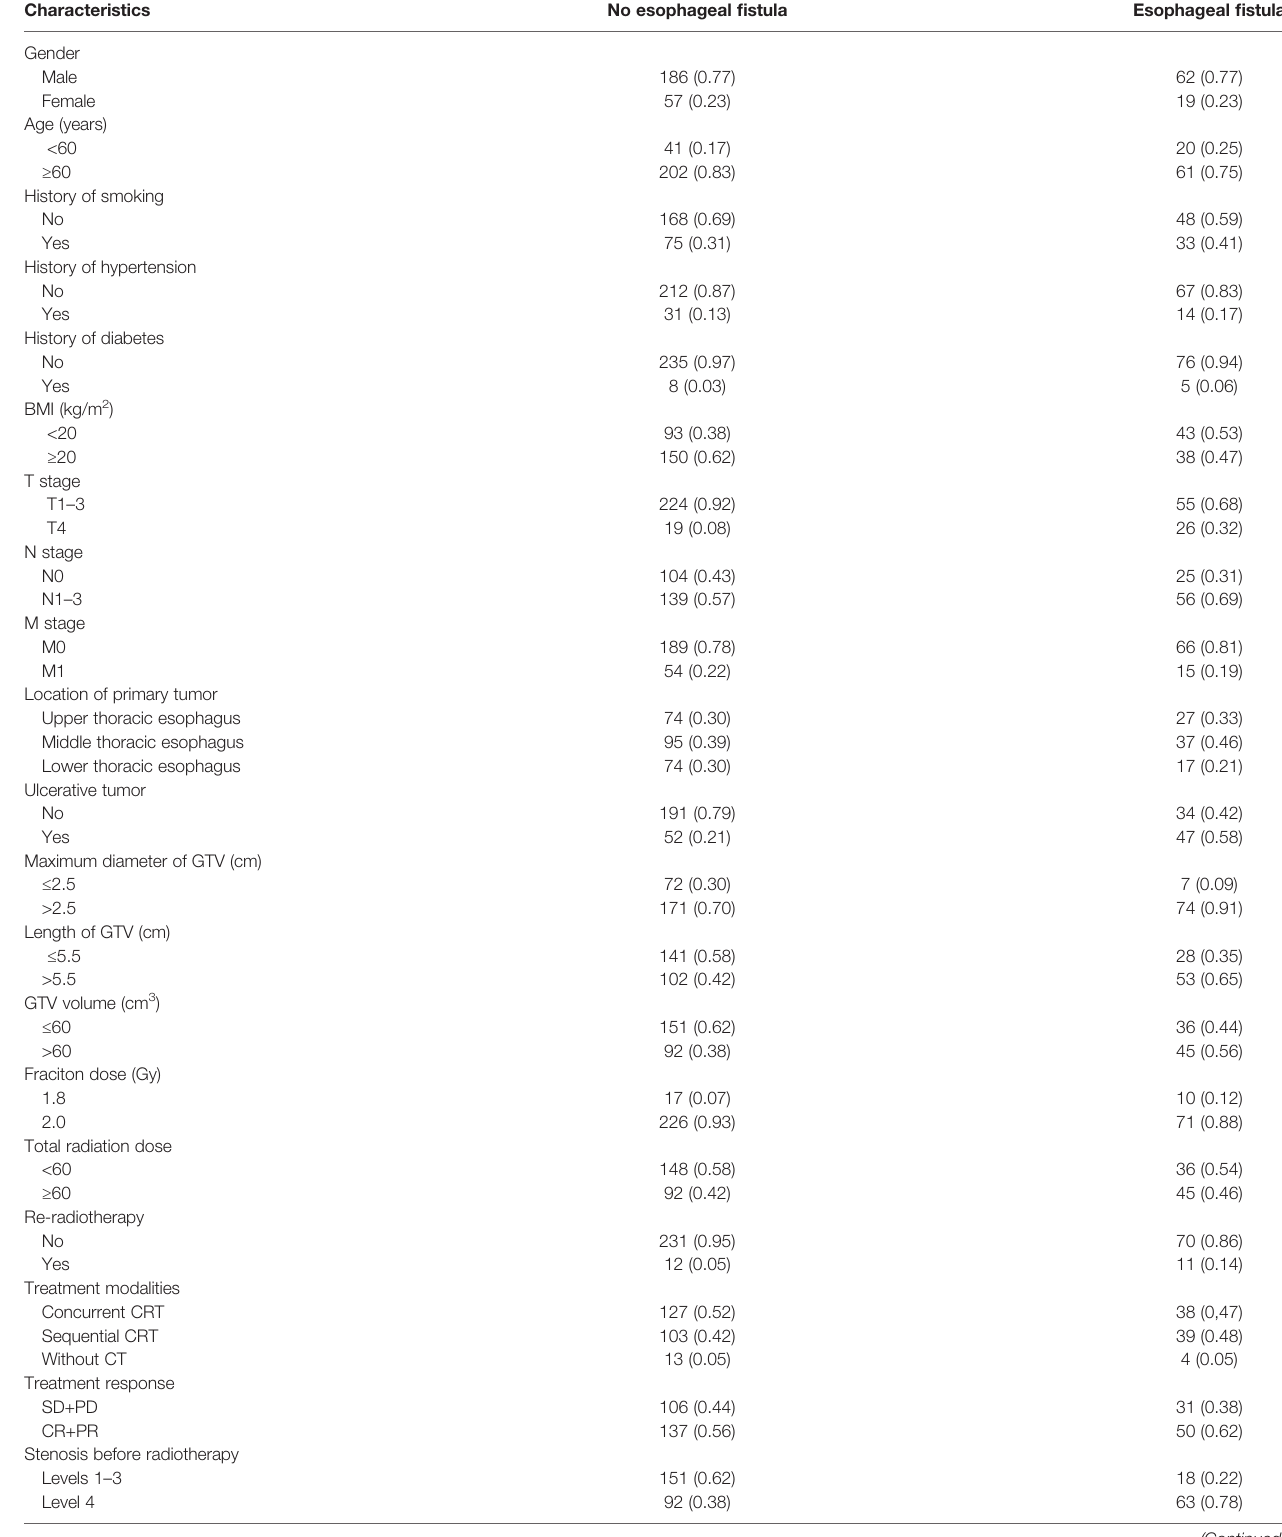
TABLE 1 | The characteristics of patients with radiotherapy-related esophageal fi stula.